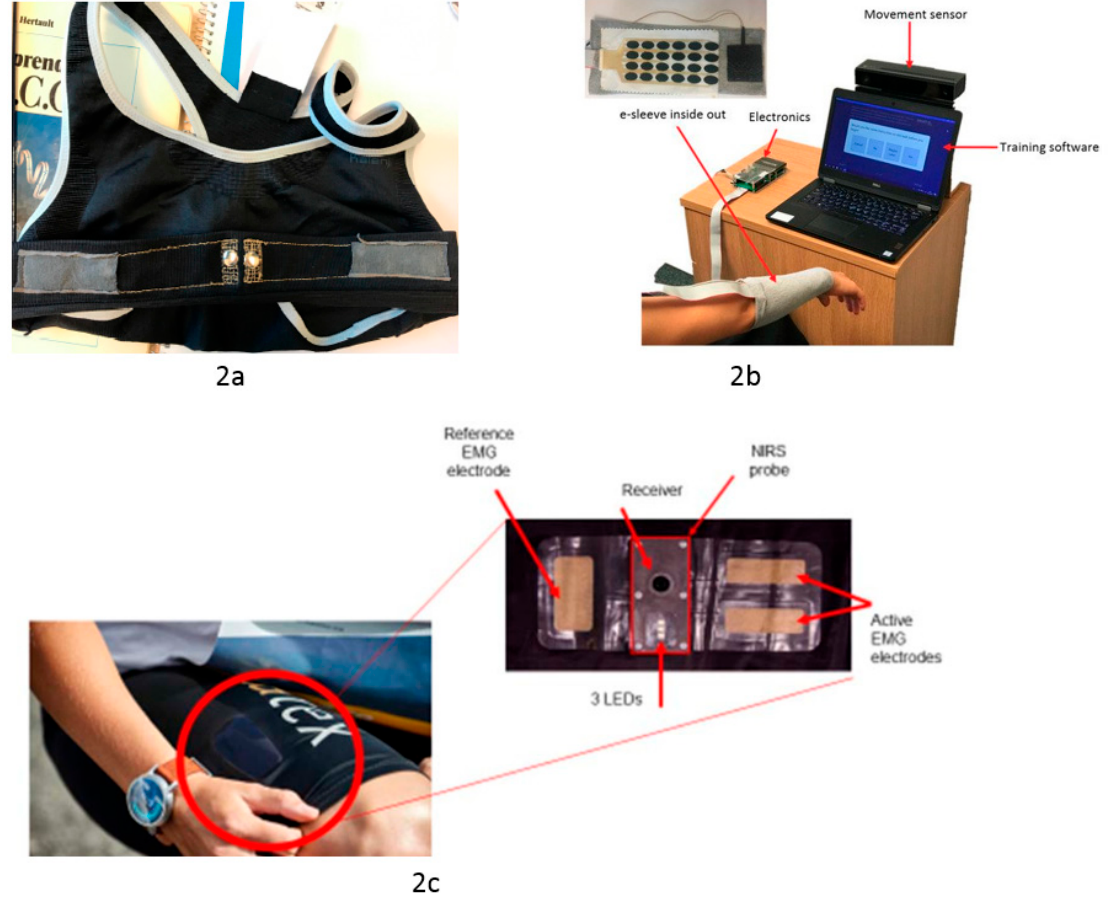
Figure 3. 2a: ECG electrode sewn in bra [86], 2b: FES electrode embedded in sleeve [8], 2c: EMG electrode integrated in clothing [88].